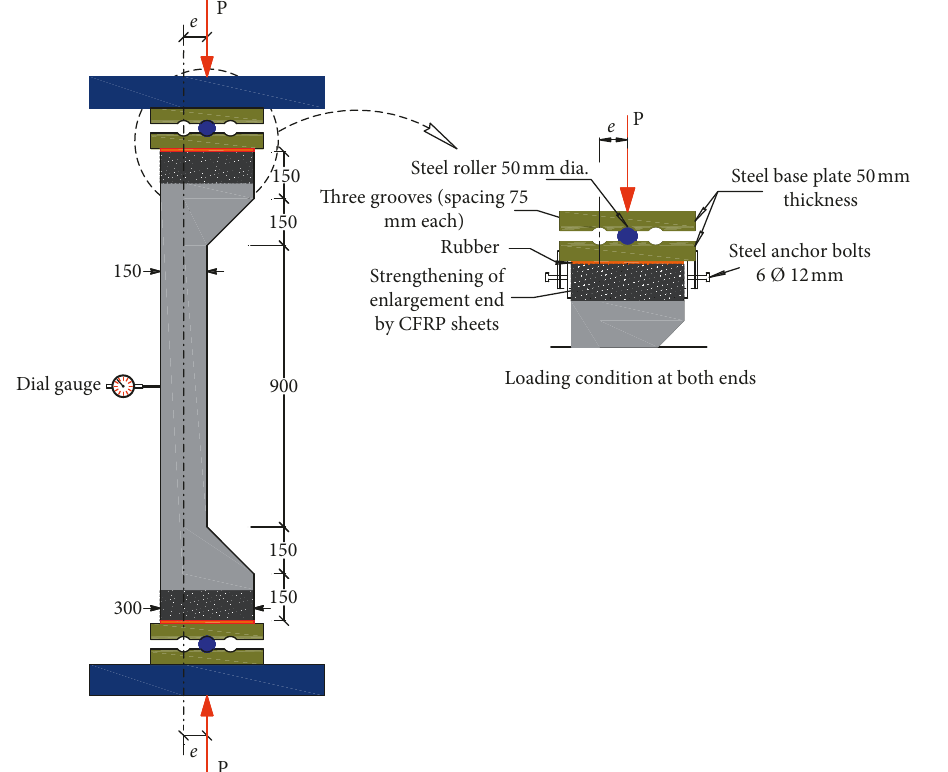
Figure 3: Loading condition at both ends of column specimens. Table 3: Experimental test results and effect of test parameters on the column axial